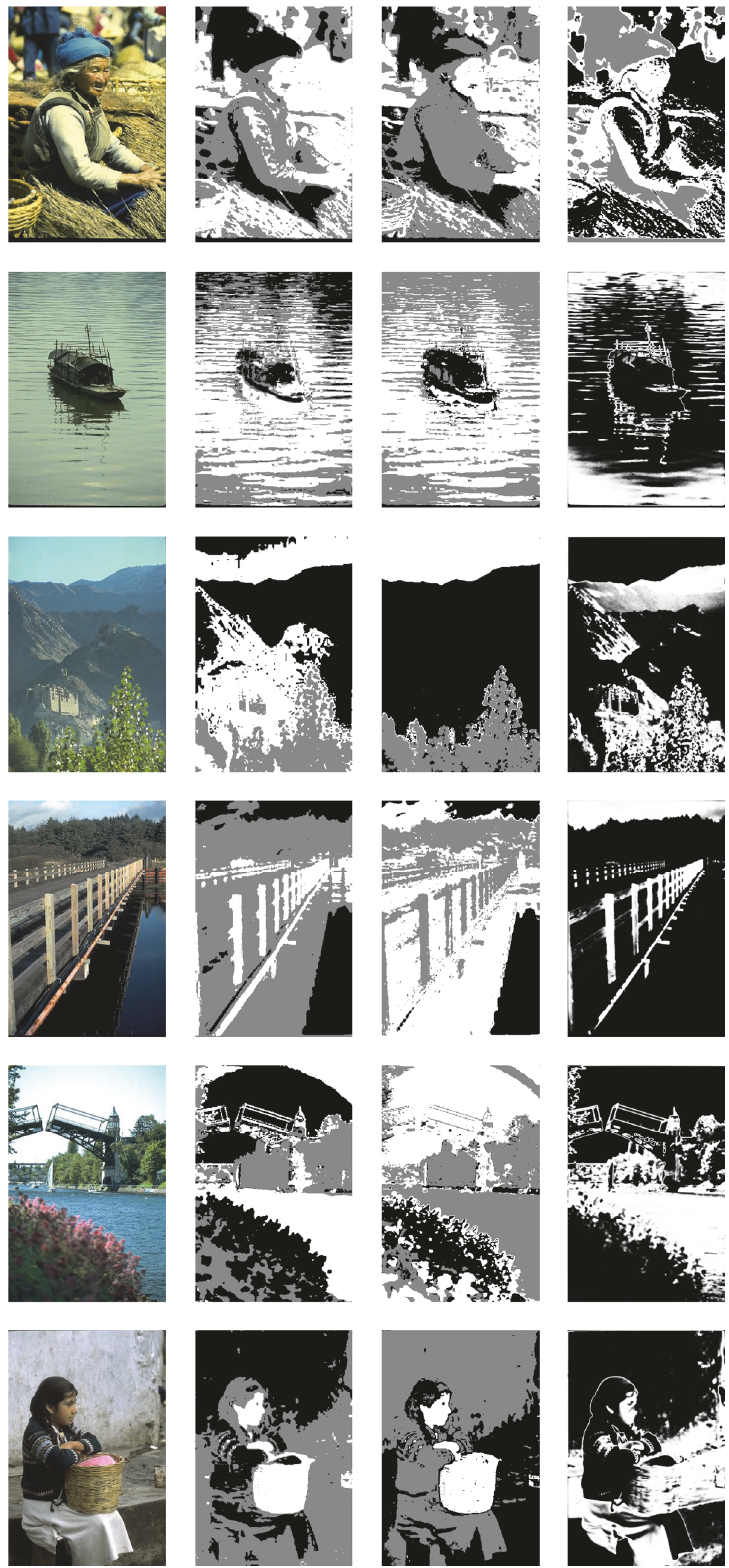
Figure 3: Original image, grayscale image using FCM, GK, and FCRM are listed, respectively